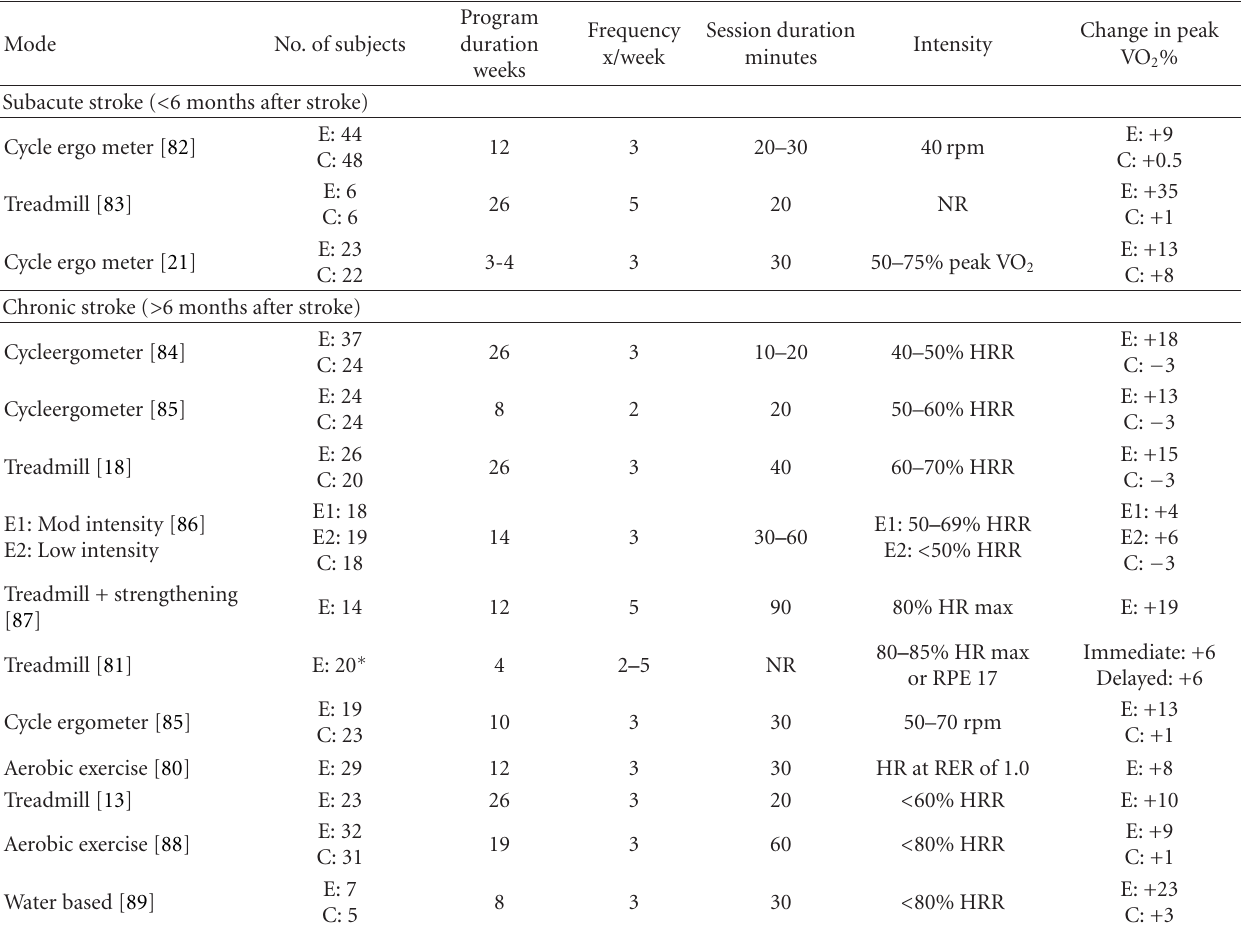
Table 1: Cardiorespiratory adaptations to aerobic training after